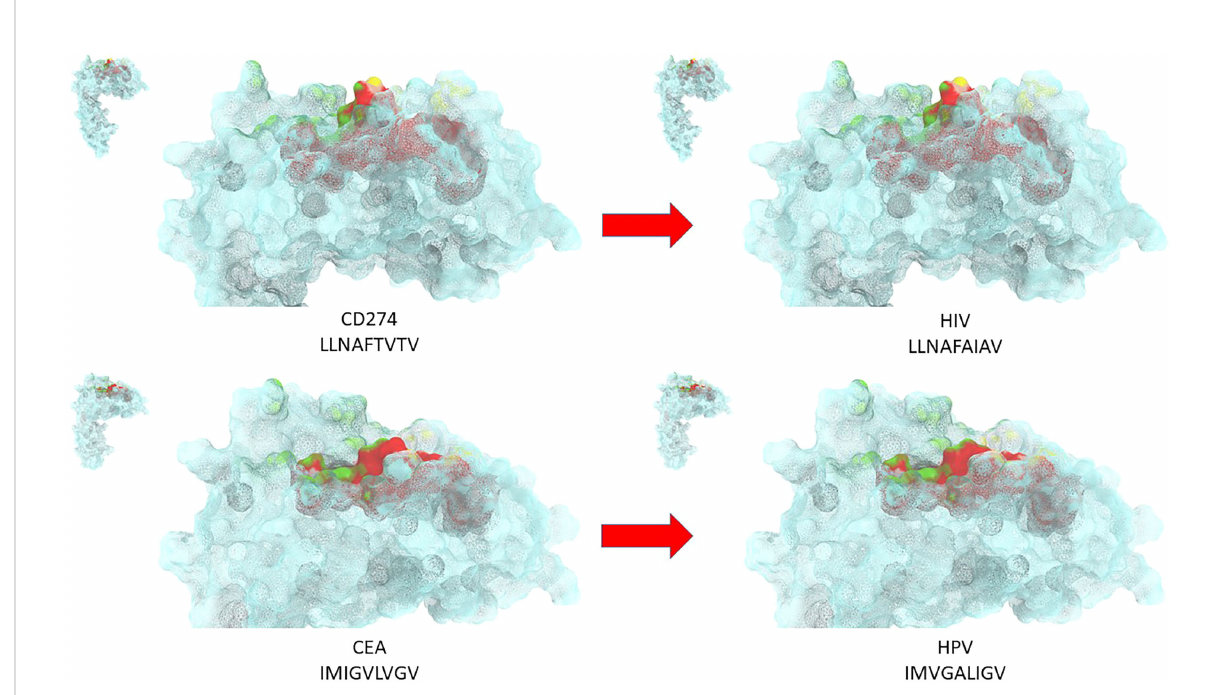
FIGURE 1 Structural predicted conformation of paired TAA and viral peptides. The conformation of the paired viral and TAA peptides bound to the HLA- A*02:01 molecule is shown. The prediction was performed using as template structure the HTLV-I LLFGYPVYV peptide crystallized with the HLA-A*0201 molecule, the b 2 microglobulin, the a and b chains of the TCR (PDB https://www.rcsb.org/structure/1AO7). Green areas = contact points with the TCR a chain; Yellow areas = contact points with the TCR b